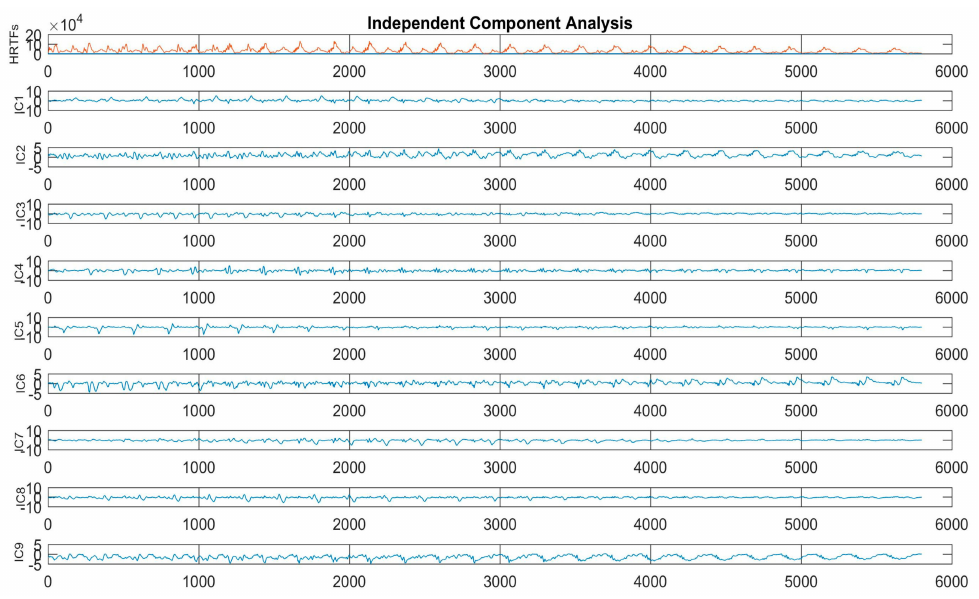
Figure 2. Independent components of head-related transfer functions (HRTFs).